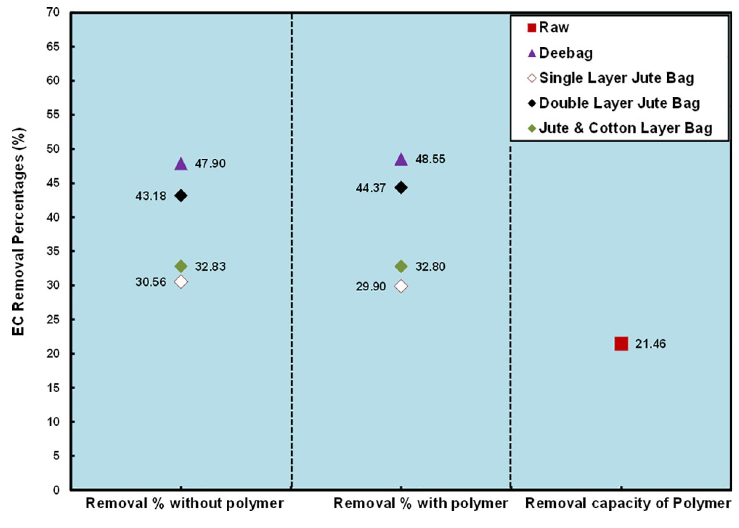
Fig 3. Removal percentages of